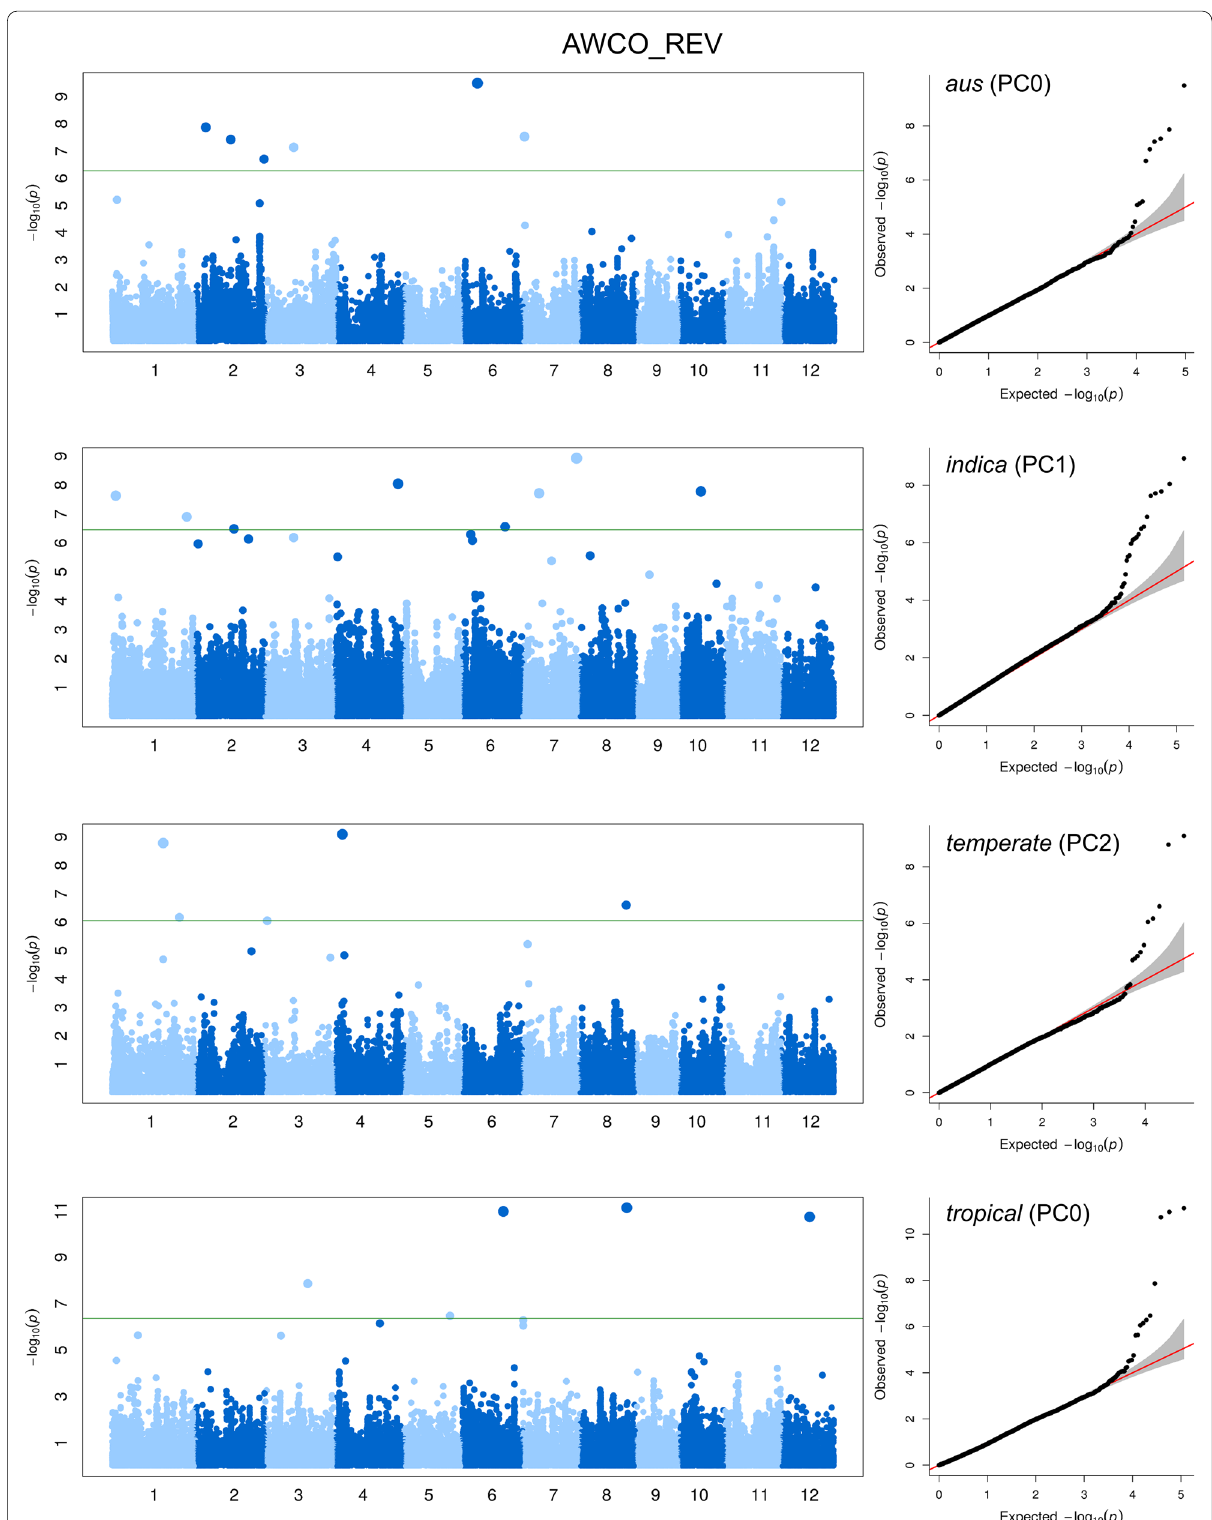
Fig. 6 GWAS results for awn color (AWCO_REV) in each sub‑population. Manhattan plot was at the left side, quantile–quantile plot was at the right side. From top to bottom: GWAS results for aus , indica , temperate japonica , and tropical japonica , the number of PC included in the final model was indicated between